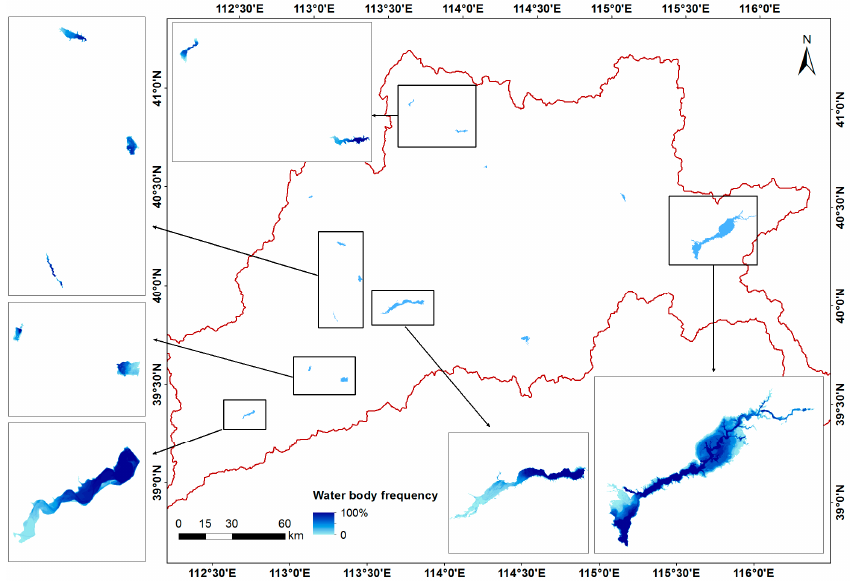
Figure 3. Landsat-derived annual surface water extent dynamics during 1985–2016 in YDRB.